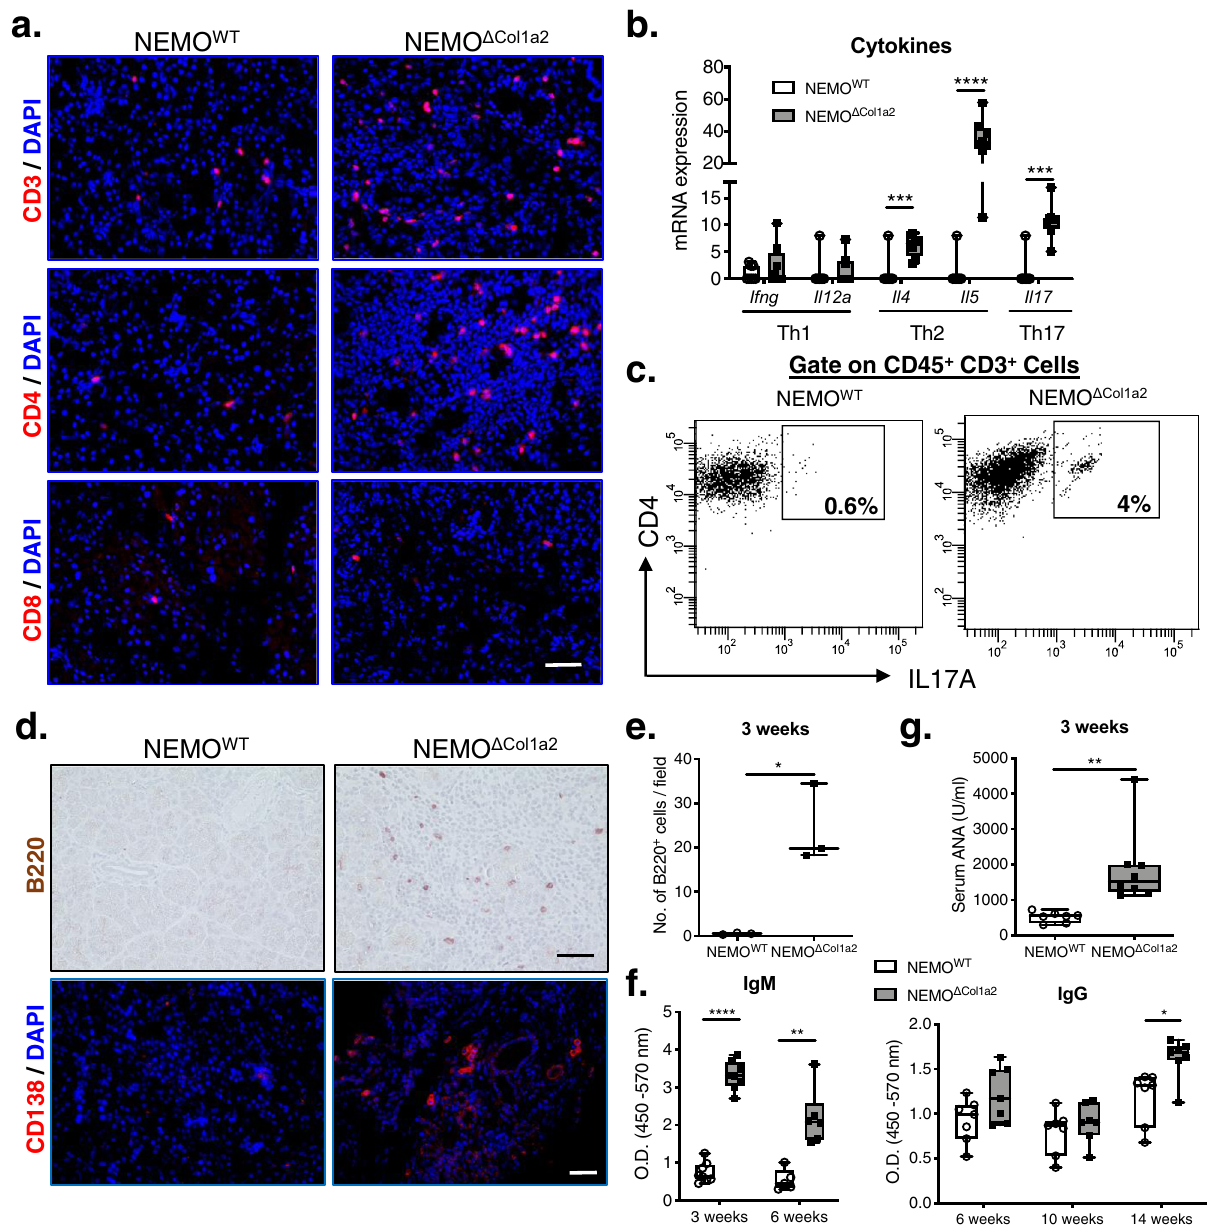
Fig. 4 Th2-predominant response promotes tissue/peripheral eosinophilia and humoral response. a CD3, CD4 and CD8 stainings on pancreatic tissues. Scale bar: 50 µ m. b Expression of Th1, Th2 and Th17 cytokines analyzed by qPCR ( n = 8). c FACS analysis showing an increase in the CD45 + CD3 + CD4 + IL17A + population in the NEMO Δ Col1a2 pancreata. d B220 and CD138 stainings showing increased B cells/plasma cells in the NEMO Δ Col1a2 pancreata. Scale bar: 50 µ m. e Quanti fi cation of B220 + cells per fi eld ( n = 3). f Measurement of the circulating IgM (3 weeks: n = 8; 6 weeks: n = 6) and IgG ( n = 7 for all time points) levels by ELISA on serum and the absorbance was determined. g Serum ANA levels measured by ELISA ( n = 8). Whiskers: Min to Max. T -test (two-tailed): * p < 0.05; ** p < 0.01; *** p < 0.001; **** p < 0.0001. All n numbers represent biological between NEMO Δ Col1a2 and AIP patients. In fact, over 90% of the enriched gene sets in AIP patients were also enriched in (Fig. 7a). NEMO WT mice recovered completely from pancreatitis after 18 weeks (Fig. 7b). The NEMO Δ Col1a2 group, however, showed NEMO Δ Col1a2 animals, though the latter also displayed additional distinctive enriched gene sets (Fig. 6d). Collectively, NEMO Δ Col1a2 a sustained fi brosis and prolonged upregulation of pro- fi brogenic animals exhibited several features of autoimmune pancreatitis and genes ( Col1a1 , Col3a1 , Fn1 and Vim ) 10 weeks after the injections with high molecular similarity to human AIP. All these results (Fig. 7c). Some of these genes remained elevated even after 18 weeks suggest that the phenotype is very likely autoimmunity in nature. ( Fn1 and Vim ). Though, from histology, eosinophil in fi ltration was reduced comparing to the 3-week time point (Fig. 7d), the expression of eosinophil markers ( Siglecf and Prg2 ) and chemokines ( Ccl6 and Ccl24 ) was still signi fi cantly higher comparing to the NEMO WT mice at these later time points. Structures of metaplastic